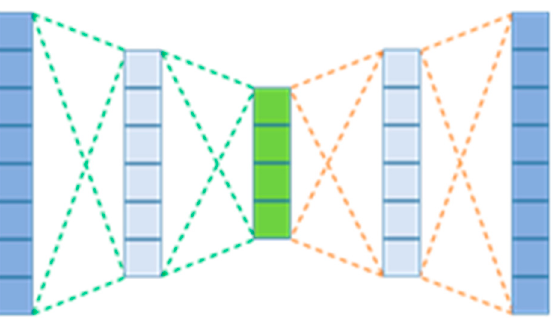
Figure 1. Autoencoder with two encoding layers displayed with green edges.